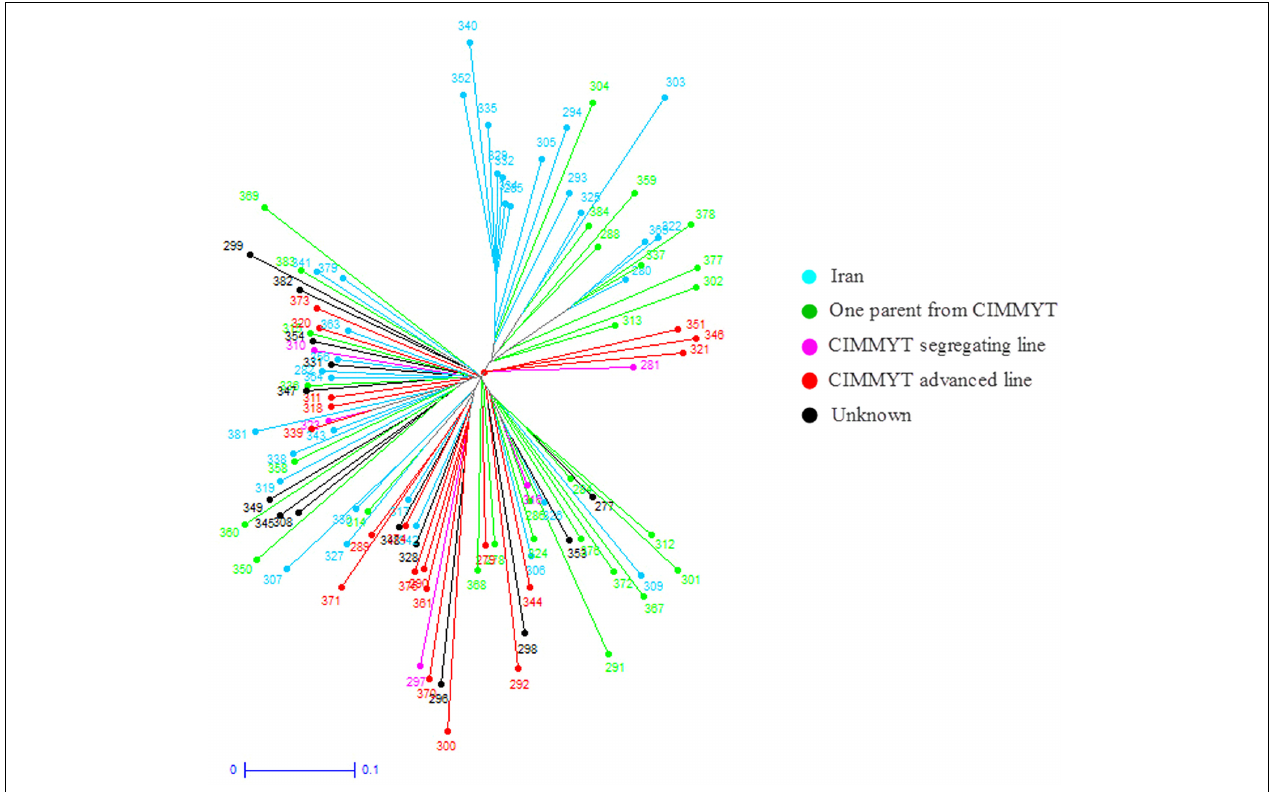
FIGURE 8 | Weighted Neighbor-Joining clustering dendrogram constructed using 16,506 SNPs and 99 Iranian hexaploid wheat cultivars to show their origins as illustrated by different colors.